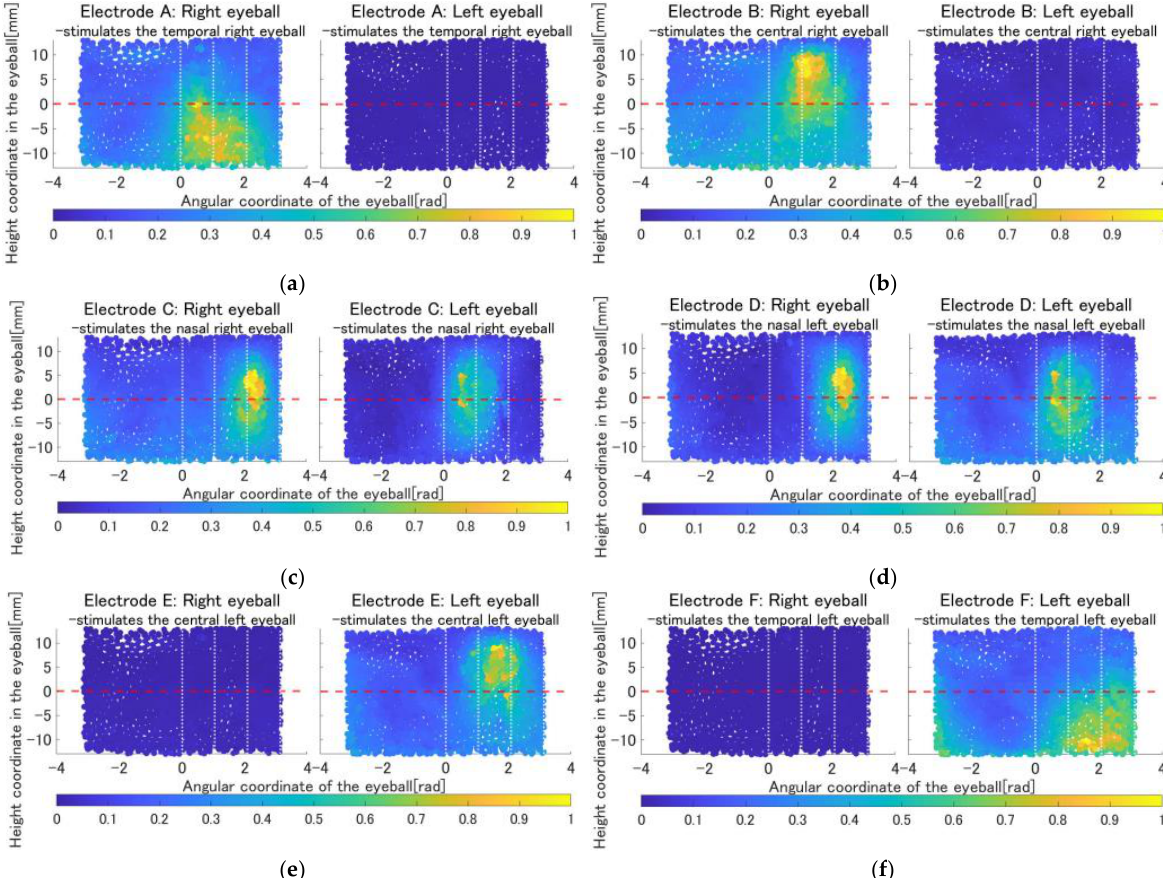
Figure 8. Simulation results obtained with electrodes for the presentation of phosphenes in three positions in the visual field: ( a ) simulation results for electrode A; ( b ) simulation results for electrode B; ( c ) simulation results for electrode C; ( d ) simulation results for electrode D; ( e ) simulation results for electrode E; ( f ) simulation results for electrode F.